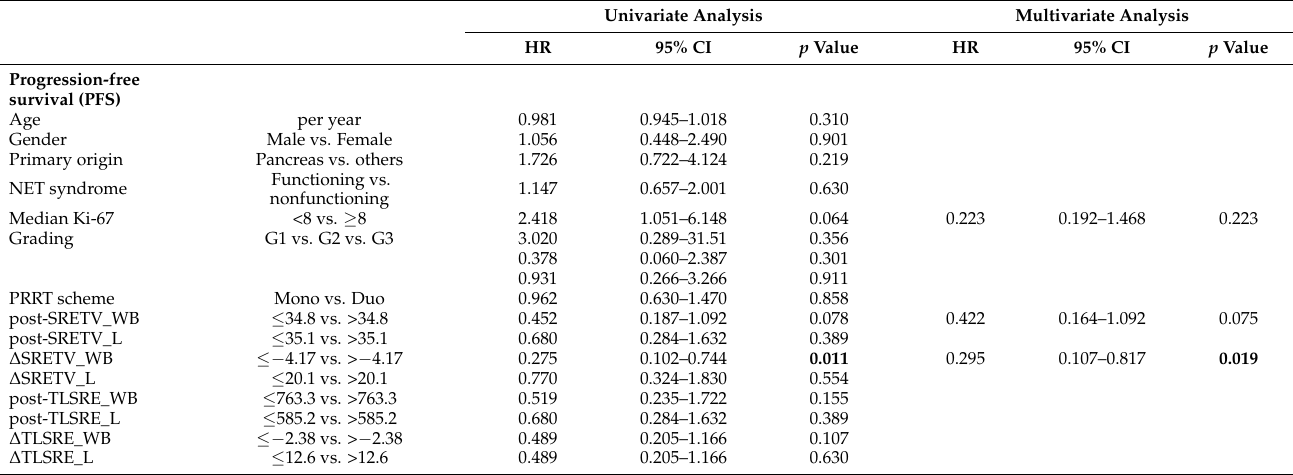
Table 2. Univariate and multivariate survival